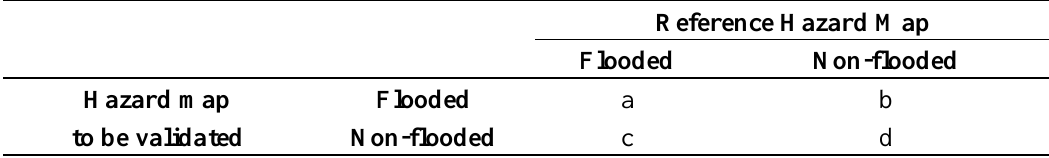
Table 2. Contingency table (np = a + b + c + d).